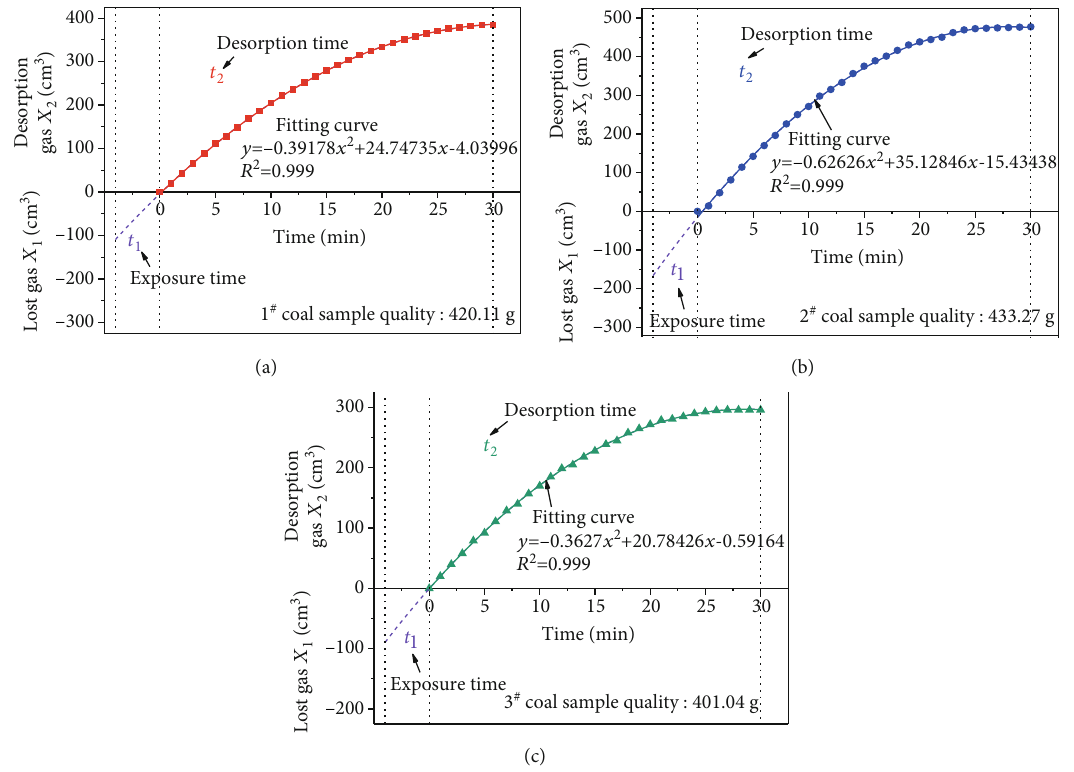
Figure 9: Fitting curve for lost gas X